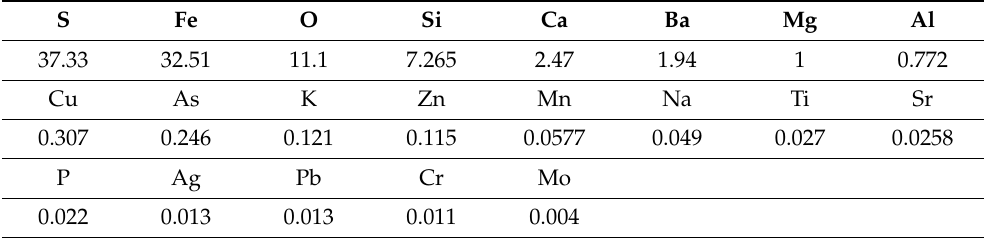
Table 1. Main chemical composition (wt%) and mass content of the sulfide ore samples.